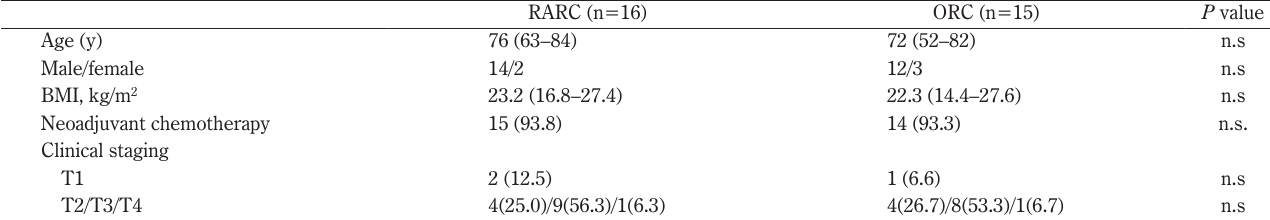
Table 3 Patients’ background in the RARC and ORC